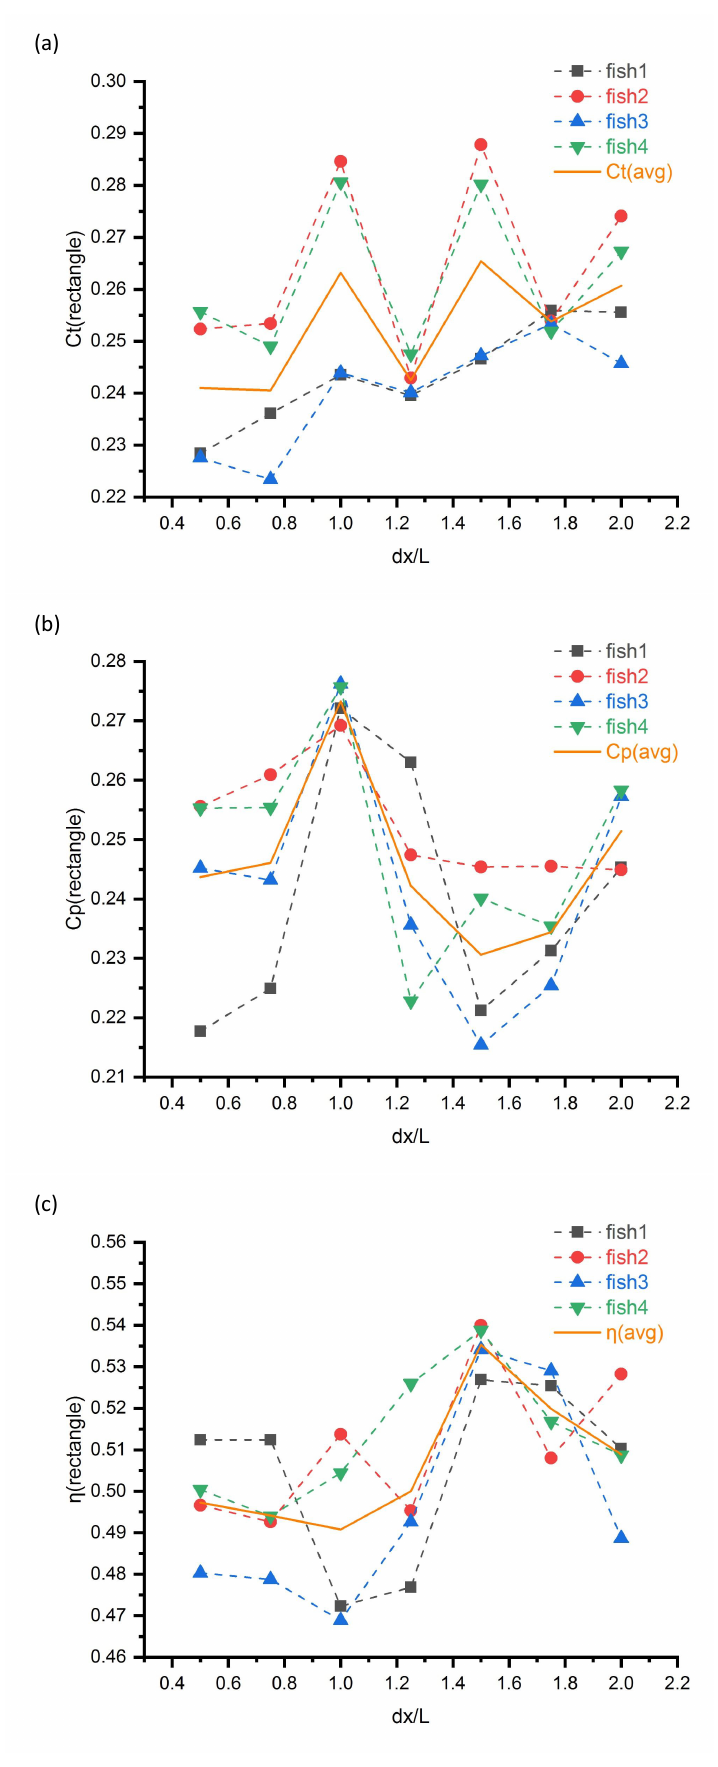
Figure 18. Results of the rectangle swarm: ( a ) non-dimensional thrust coefficients C t , ( b ) non-dimensional lateral power loss coefficients C p , ( c ) the Froude efficiency η